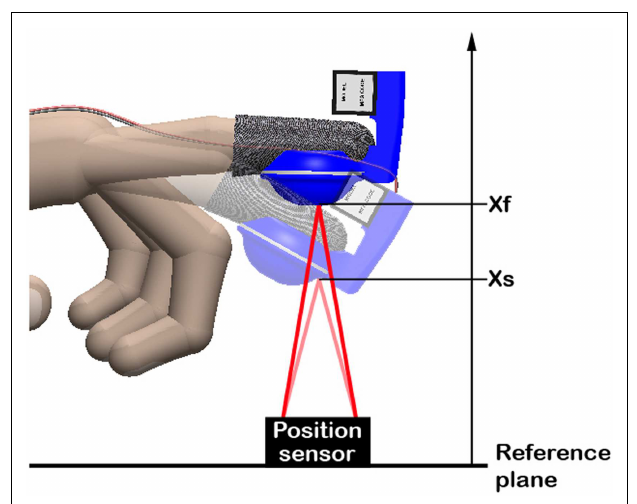
FIGURE 5 | Schematic representation of the movement that volunteers where asked to perform during the psychophysical test .